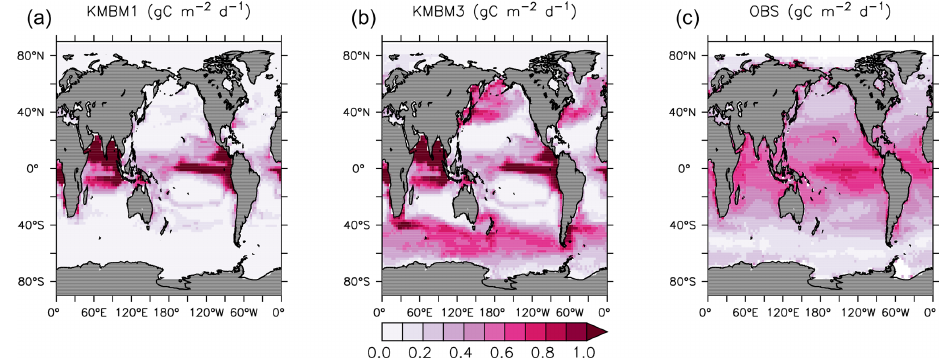
Figure 3. Comparison of model NPP output at 2014 ( a Keller et al., 2012; b this model) and satellite-derived NPP climatology (NASA, 2018), 2012–2018 (c) in gCm − 2 d − 1 .